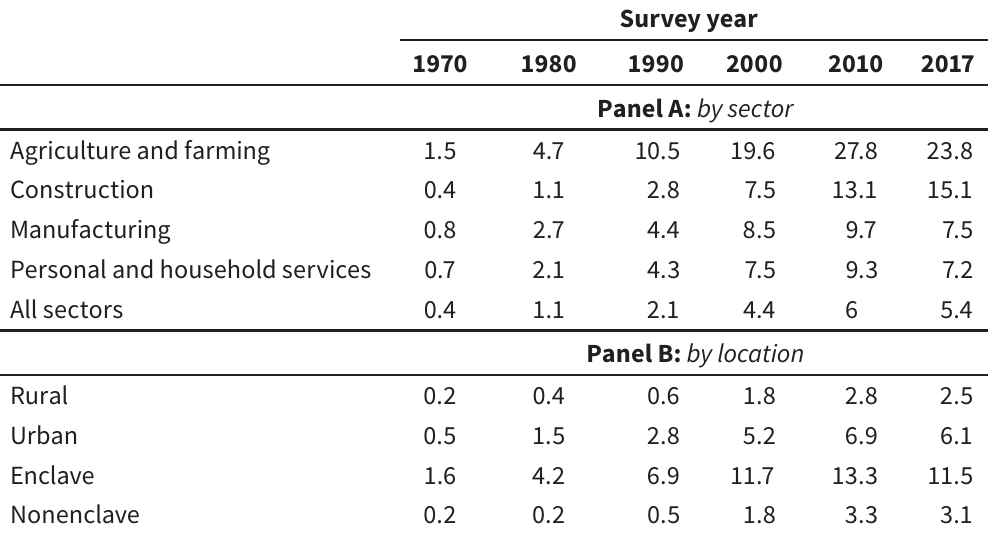
Table A3 Percentage of workforce composed of Mexican and Central American immi- grants by sector and